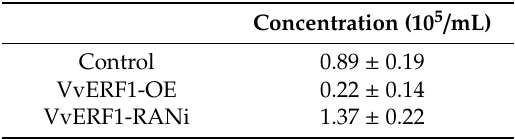
Figure 12. E ff ects of VvERF1 on strawberry fruit with transient expressions of VvERF1-OE, VvERF1-RNAi. ( A ) Strawberry fruit was inoculated with B. cinerea and sampled at 0, 2, 4, and 6 d. ( B ) Disease incidence. ( C ) Disease lesion diameter. Values are means ± SD of five biological replicates. * and ** Significant differences compared with the control (water-treated fruits) sample at p < 0.05 and p < 0.01, respectively using Student’s test, d: day. Table 1. Biomass of fungus on the VvERF1-OE and VvERF1-RNAi in strawberry fruits.